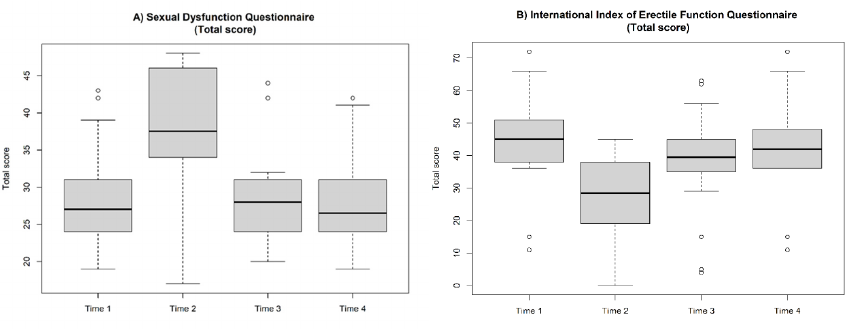
Figure 1. Box and whisker plots depicting sexual dysfunction ( A ) and erectile function ( B ) from the total points of the questionnaire administrated to 22 COVID-19 patients in the periods before being tested (Time 1), during quarantine (Time 2), 1 month after a negative test (Time 3), and 3 months after a negative test (Time 4). Boxes denote the interquartile range. The solid black horizontal bar denotes the median within each time period. Whiskers denote the 95% range of the distribution of tumor size. The open circles denote outlier values. Table 4. Sexual distress schedule administrated to 22 COVID-19 patients in the periods before being tested (Time 1), during quarantine (Time 2), 1 month after a negative test (Time 3), and 3 months after a negative test (Time 4).